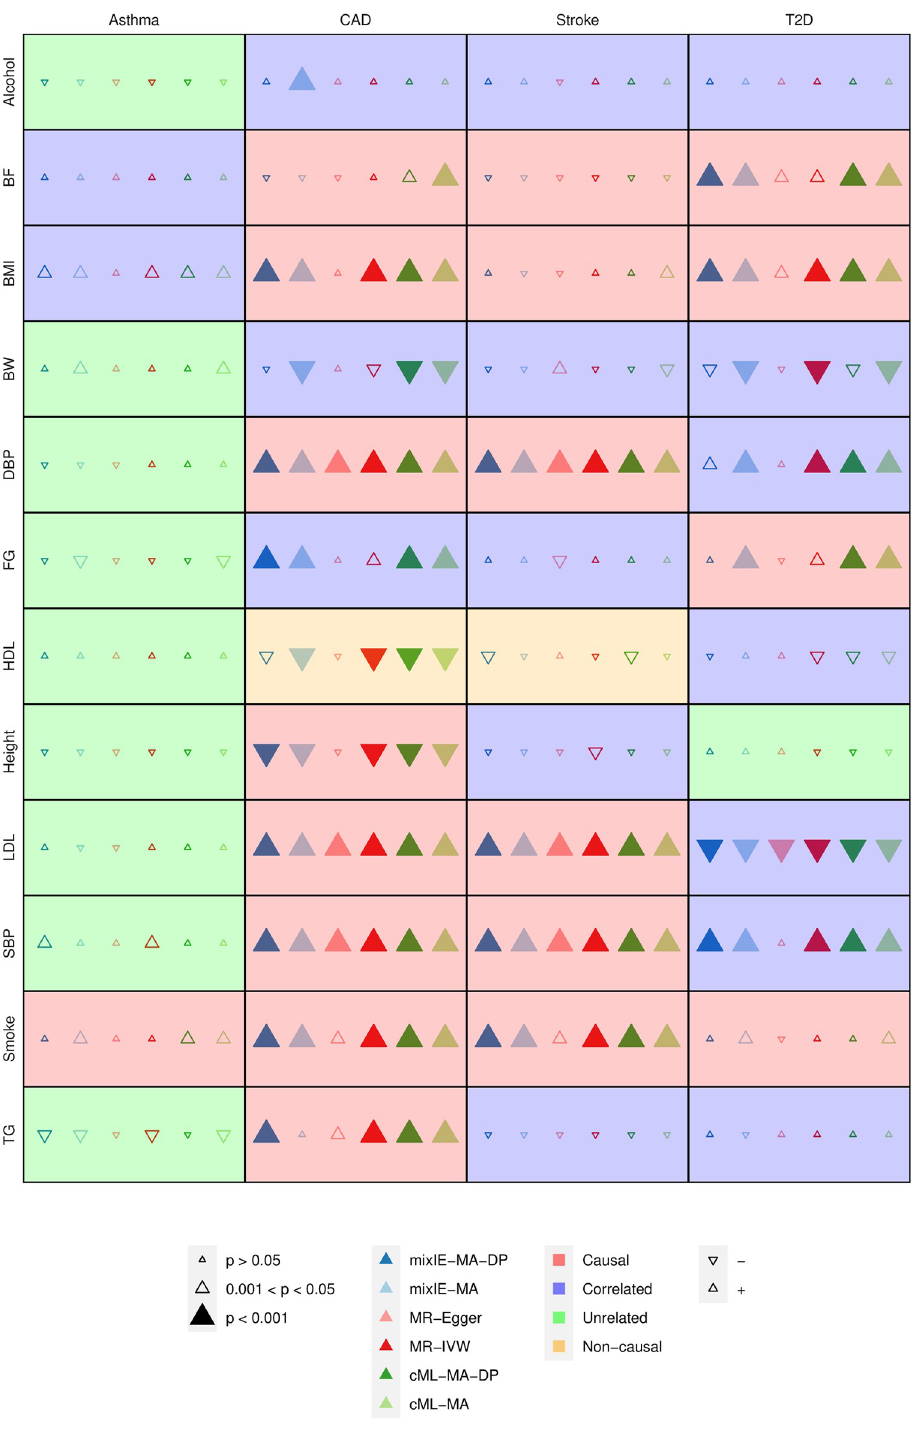
PLOS Genetics | https://doi.org/10.1371/journal.pgen.1009922 November 18,